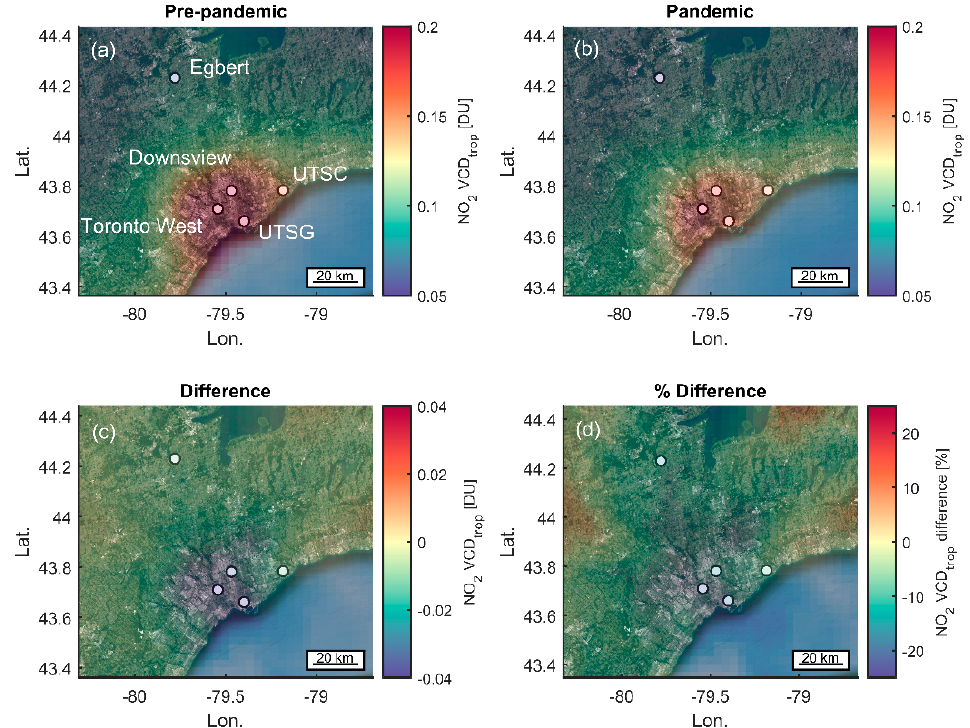
Figure 9. TROPOMI ECCC recalculated tropospheric NO 2 columns smoothed by pixel averaging (with observations from 15 March to 15 September for each year). Pandora sites show as white dots. the pandemic (i.e., 2020–2021); ( c ) difference between the two periods; ( d ) percentage difference between the two periods. Base map from Google Maps © .